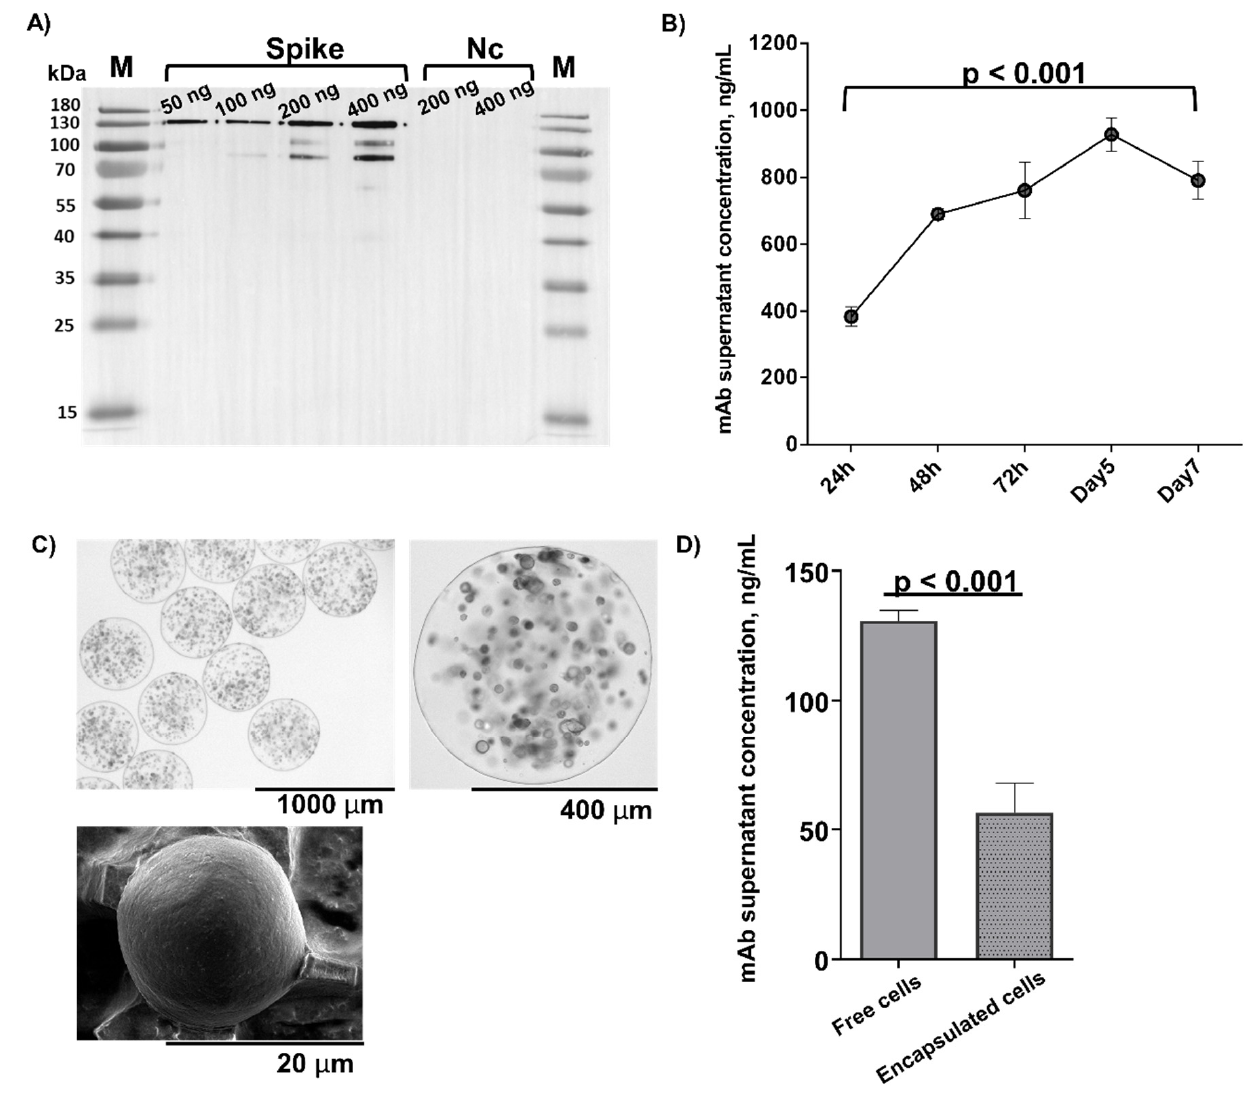
Figure 1. SARS-CoV-2 monoclonal antibody production in cells transfected with the CR3022 heavy and light chains. For western blot analysis ( A ) different amounts of Spike (50–400 ng) and nucleocapsid (Nc, 200–400 ng) proteins were separated on a 10% SDS–PAGE gel, transferred onto a PVDF membrane and then blotted with G-8 cell culture supernatant; probing was done using an HRP-conjugated rabbit IgG specific to both the heavy and light chains of human IgG. Lanes M: protein ladder; Spike lanes: S protein at 50, 100, 200, and 400 ng. Lanes N: N protein at 200 and 400 ng. kDA = kilodaltons. ( B ) CR3022 expression in cultured G-8 cells quantified using receptor binding domain (RBD) ELISA and normalized to the untransfected supernatant readout. Cell media were changed every 24 h. Lines and brackets represent the geometric means and 95% confidence intervals, respectively. ( C ) Microphotographs of G-8 cell-containing alginate microcapsules obtained using light (top left panel at ×4 and top right panel at ×10 magnification) and electron microscopy (bottom left panel at ×800 magnification). ( D ) Supernatants collected from free and encapsulated G-8 cells stably expressing CR3022 at 48 h after last media change. Supernatants (at 1/100 dilution) were incubated on RBD-coated ELISA plates. Lines and brackets represent the geometric means and 95% confidence intervals, respectively. In ( B , D ): mAb concentrations were calculated using a standard curve generated using a CR3022 mAb (NR-52481) from BEI on experimental readouts normalized to the corresponding baseline control (untransfected supernatant) OD readouts (see Methods).